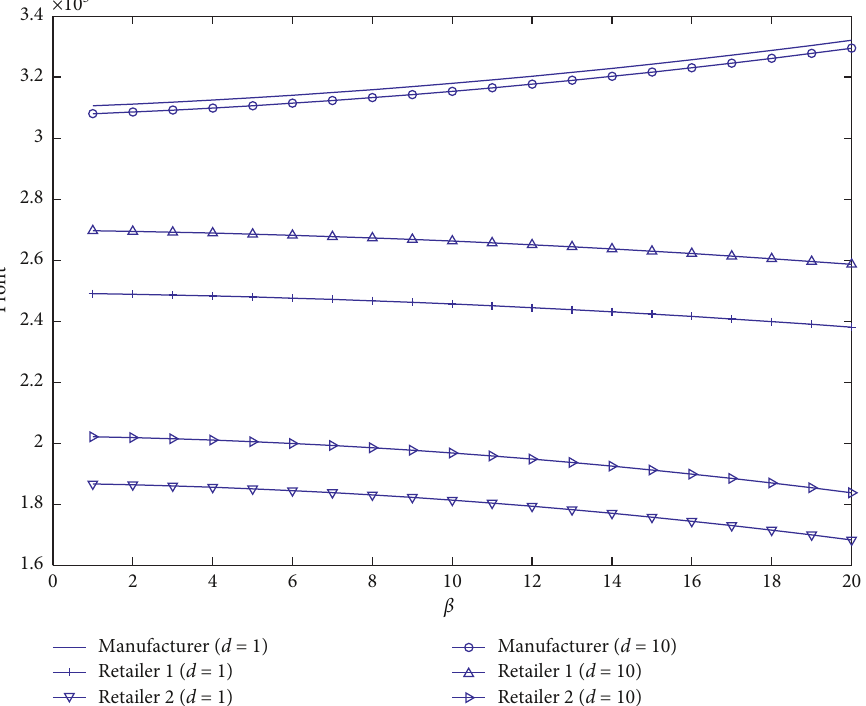
Figure 6: Effect of the competition coefficient on the profit of supply chain members under decentralized